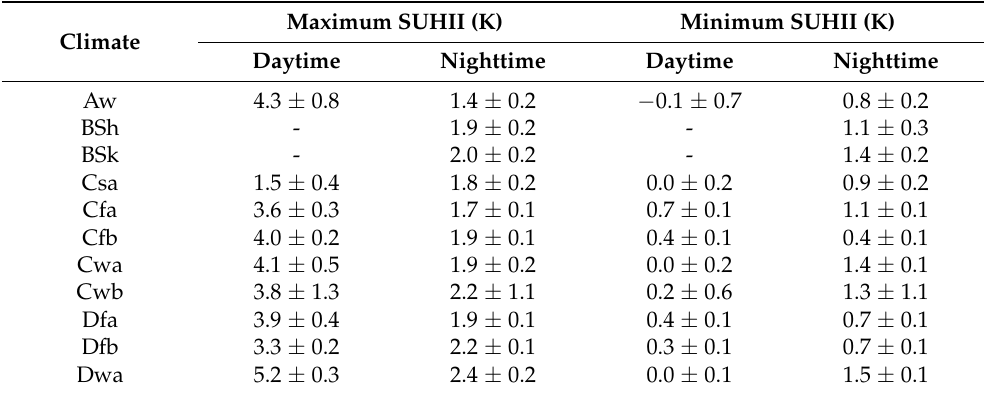
Table 4. The minimum and maximum SUHII (and the 95% confidence intervals) for the Köppen– Geiger climate-class means shown in Figures 8 and 9 (black